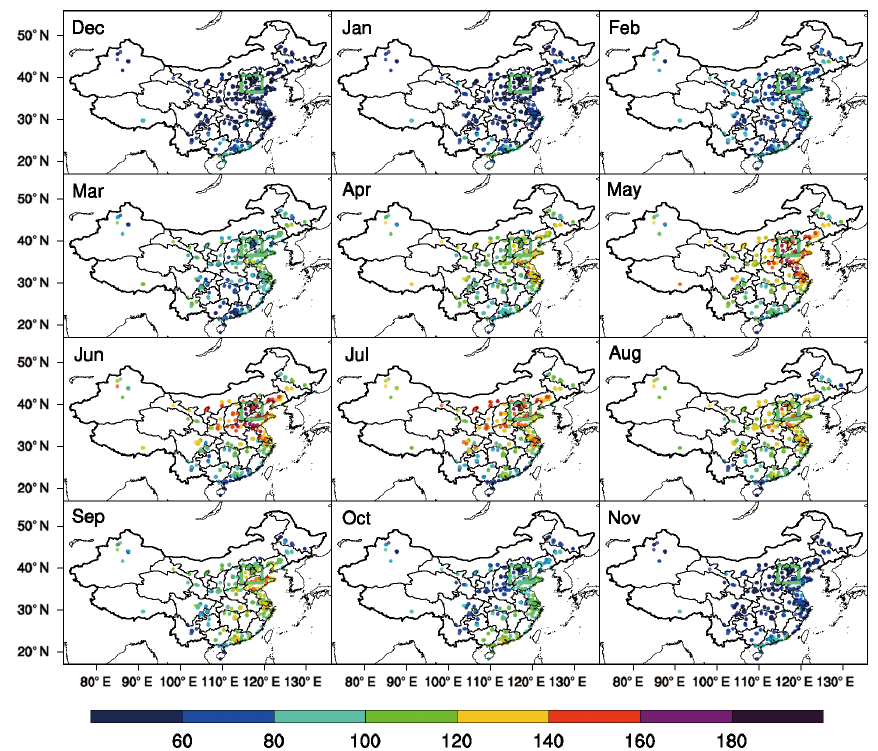
Figure 1. Monthly MDA8 O 3 concentrations (µgm − 3 ) averaged over 2014–2017 at 740 observational sites. The solid green lines indicate the North China